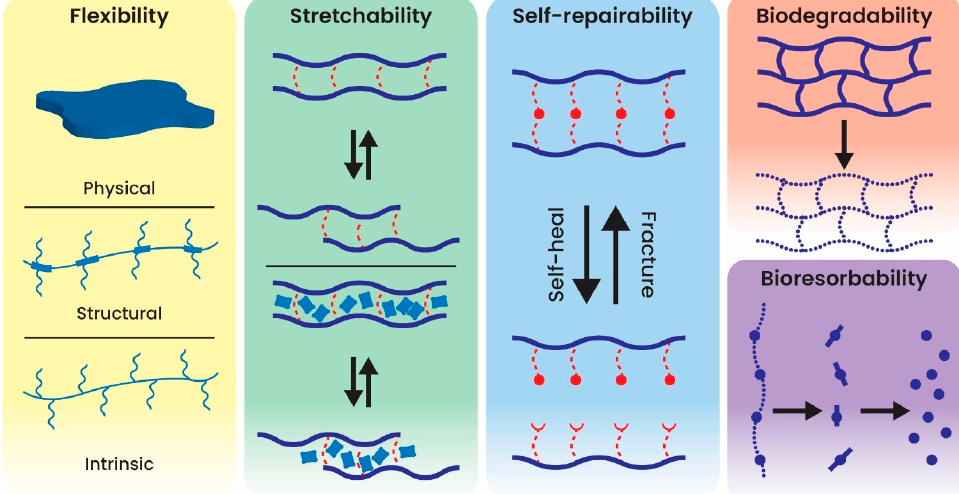
Figure 2. Representation of the properties desired in materials aimed for implantation applications.